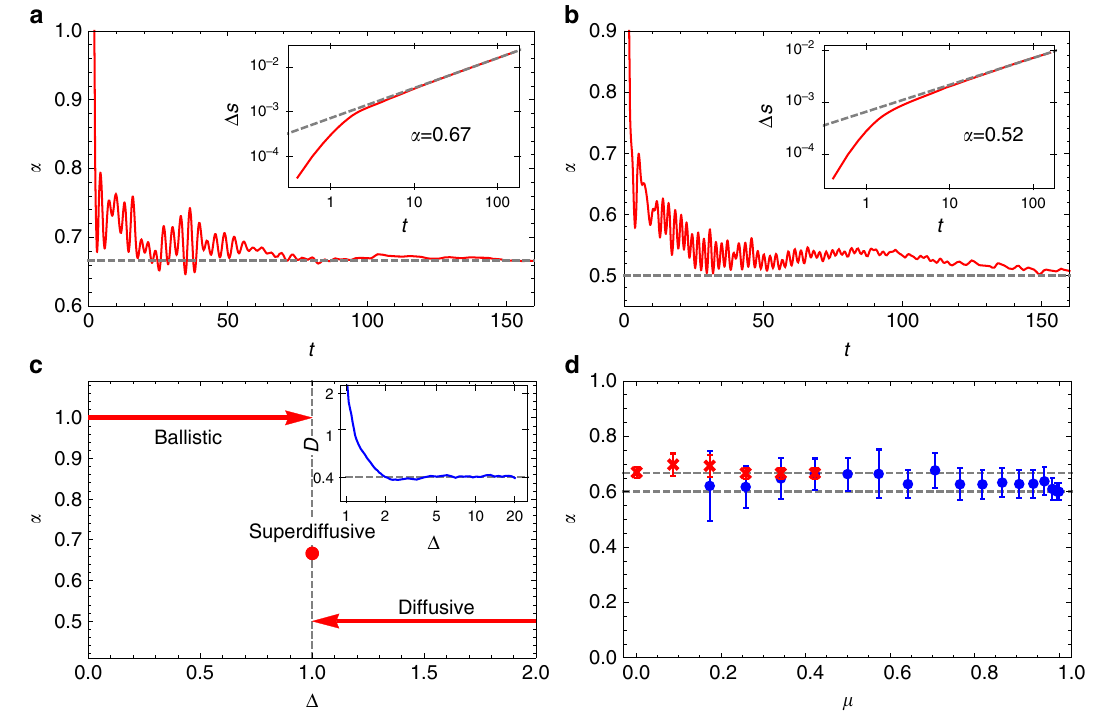
Figure 2 | Scaling exponents of magnetization spreading. ( a , b ) Local exponent a ( t ) calculated as a numerical log-derivative d log D s ( t )/d log t for D ¼ 1 ( a ) and D ¼ 2 ( b ) (dashed lines indicate exponents 2/3 and 1/2, respectively, while dashed lines in the insets show best power-law fits to D s ( t )—red curve), both for m ¼ p /1,800. ( c ) Conjecture for the dependence a ( D ) at high temperatures and small m . The inset shows the diffusion constant obtained from Fick’s law for various values of D in the diffusive regime, converging to a finite value at large D (agreeing with ref. 28). ( d ) Dependence on m for D ¼ 1 shows a small but significant change in the behaviour: for m E 1 it is closer to a ¼ 3/5 while for small m it becomes close to a ¼ 2/3 (dashed). The blue (circles) and red (crosses) symbols represent wave function and density operator evolutions respectively. We average over samples of 10–130 random initial wave-functions for each blue data point. For intermediate m the error-bars (denoting the estimated s.d.) are larger since the simulation is less efficient in that regime (Methods